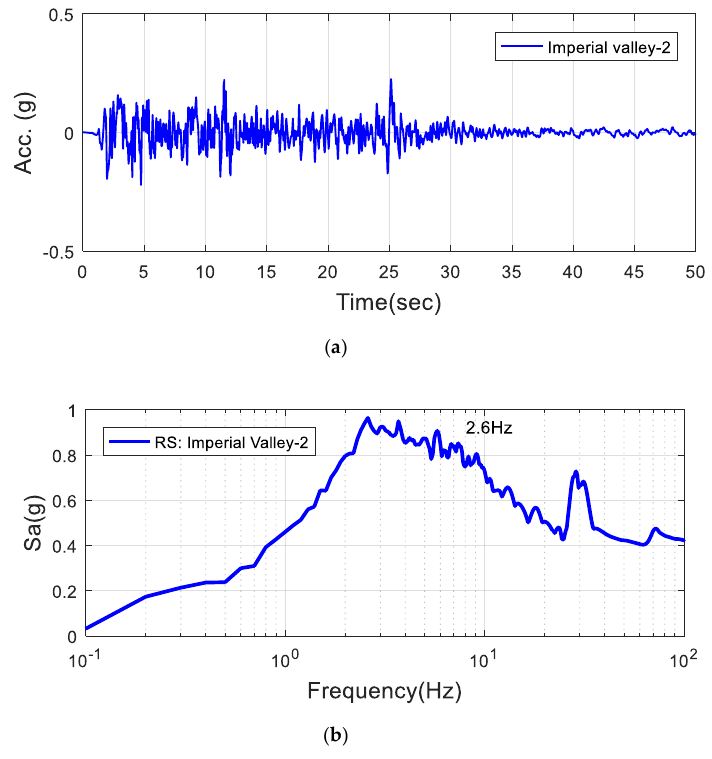
Figure 14. Imperial valley-2 earthquake: ( a ) time history and ( b ) response spectrum.